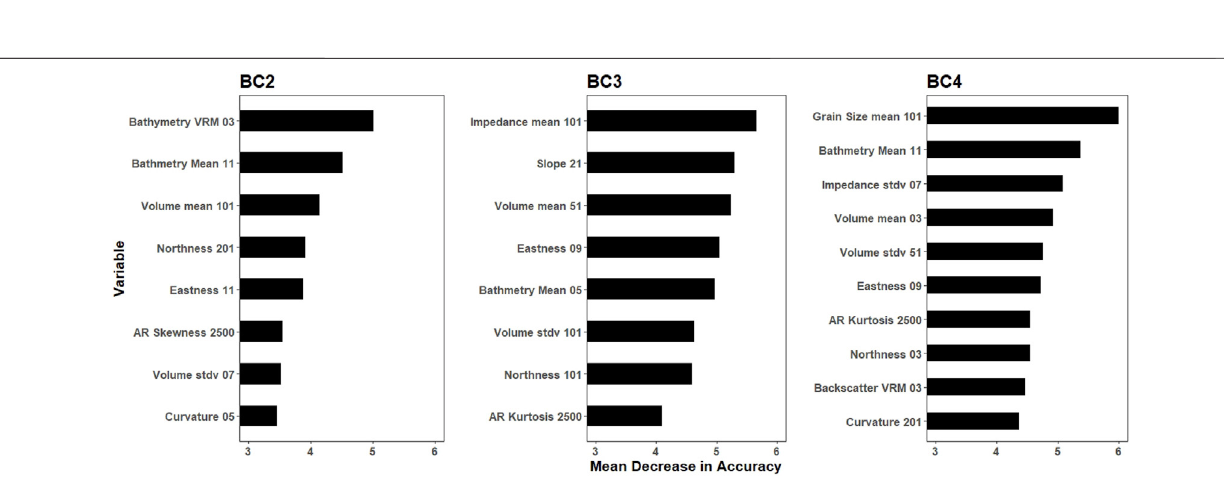
FIGURE 9 | Retained model variable importance for medium scale segmentation. The higher mean decrease accuracy the more important the variable is for the model.